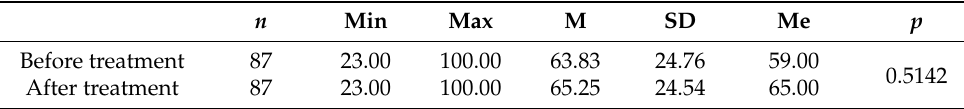
Table 3. Chemotherapy cycle versus SBI index.